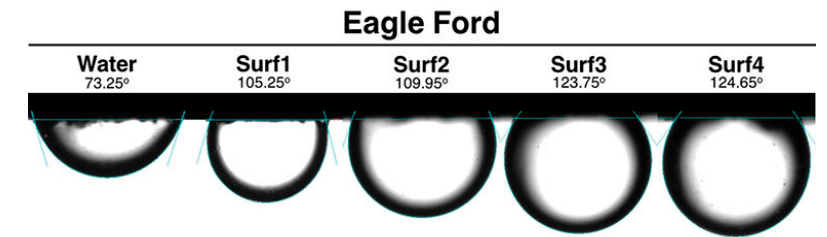
Figure 15. ( a ) Conceptual model of the movement of a non-wetting phase from the bulk reservoir to a narrowing pore throat, displacing a wetting phase. The capillary pressure increases up to the Figure 16. Contact angles for oil drop, adhering to oil–wet shale surface, varies with surface tension. maximum value Pc given by Young–Laplace equation. ( b ) Movement of non-wetting phase from a Addition of various surfactants (Surf 1–4) to the pure interstitial water (left) leads to an increasing channel to the bulk of the reservoir and the corresponding pressure profile. degree of the surface repelling the oil drop. The most effective surfactant (Surf 4) causes the most separation from the surface. Source: Dr. David Schechter, Texas A&M University.